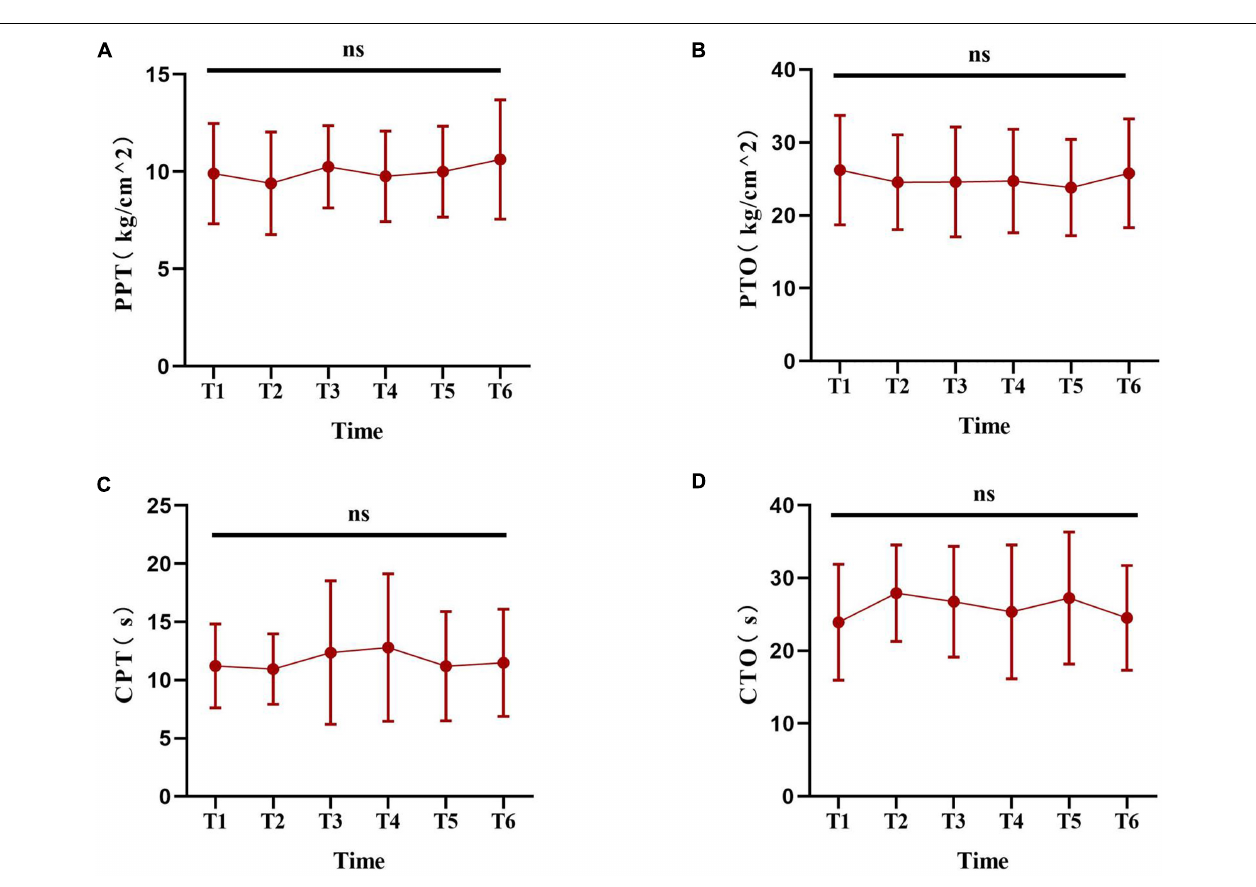
FIGURE 1 | Flow chart of the study. (A) Each subject was tested in the chronological order from test point 1 to test point 6. (B) Each parameter was measured according to the listed sequence.